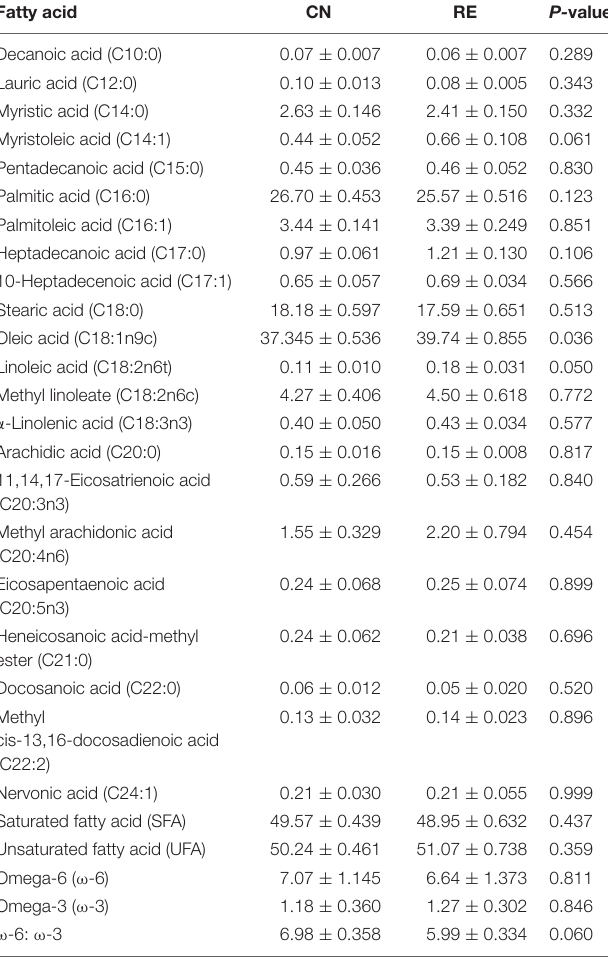
TABLE 5 | Effects of herbal tea residue feed on the fatty acid content of beef (g/100